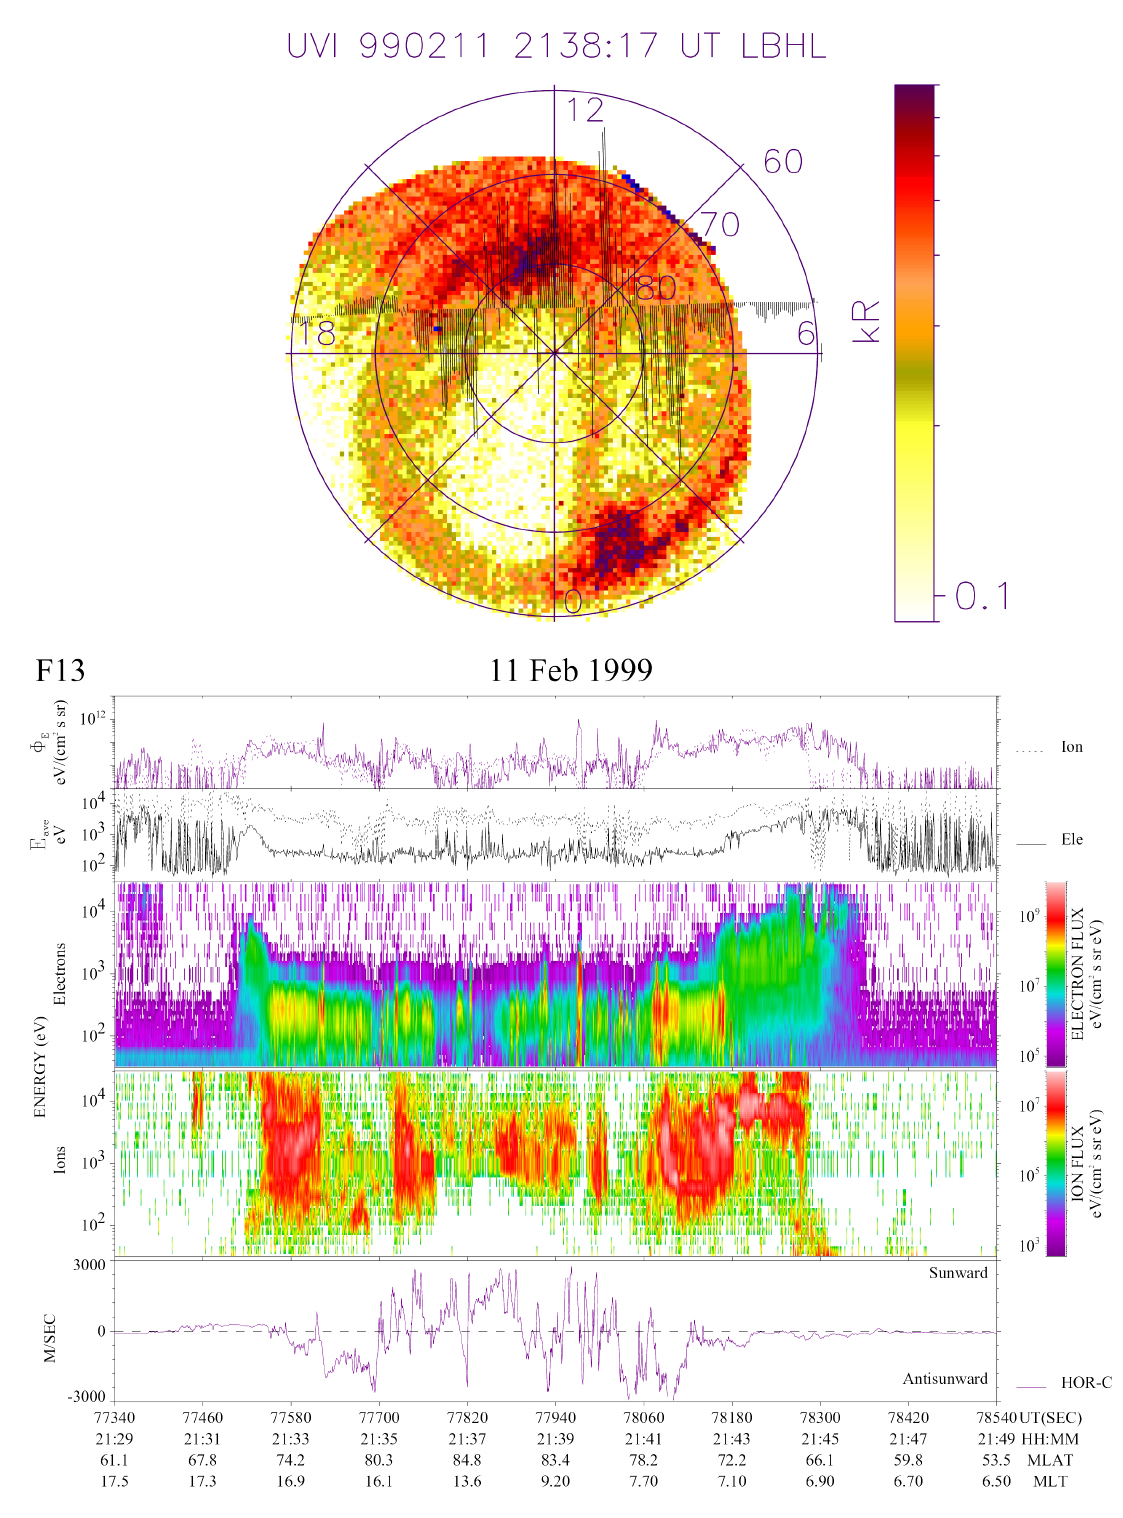
Fig. 8. Data shown from the second DMSP pass on 11 February 1999 (21:29–21:49 UT) that occurs during the UVI data period. Same format as Fig. 7. See text for